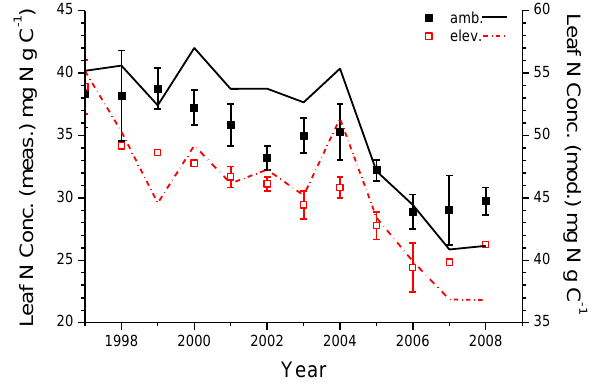
Fig. 7 Fig. 7. Leaf N concentrations measured (symbols) and modelled (lines) from 1998 to 2008 under ambient ( ∼ 370µmolmol − 1 ) vs. elevated ( ∼ 550µmolmol − 1 ) C a without N fertilizer at the ORNL FACE experiment. Measured data from Norby et al. (2010), with er- ror bars representing standard errors from replicated measurements ( n =